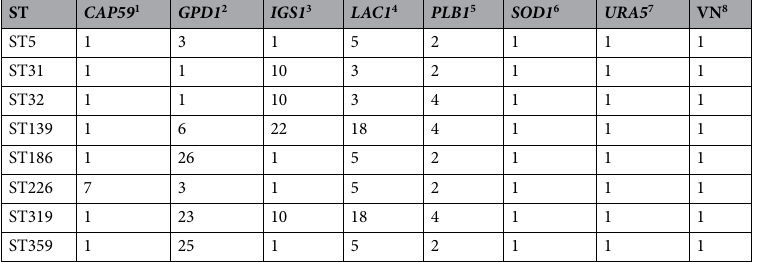
Table 2. Allelic assignments of the eight multilocus sequence types found in this study. 1 CAP59: Allele #1 has been found in 139 known STs; allele #7 in 55 STs. 2 GPD1 : Allele #1 has been found in 106 known STs; allele #3 in 32 STs; allele #6 in 6 STs; allele # 23 in 20 STs; allele #25 in one ST (i.e. ST359); and allele #26 in one ST (i.e. ST186). 3 IGS1 : Allele #1 has been found in 124 known STs; allele #10 in 33 STs; allele #22 in one ST (ST139). 4 LAC1 : Allele #3 has been found in 65 known STs; allele #5 in 31 STs; and allele 18 in 39 STs. 5 PLB1 : Allele #2 has been found in 68 known STs; allele #4 in 71 STs. 6 SOD1 : allele #1 has been found in 183 STs. 7 URA5 : allele #1 has been found in 91 STs. 8 VN: These eight STs found in Jiangxi are among 487 total STs in the VNI molecular type in the MLST database accessed on September 16,